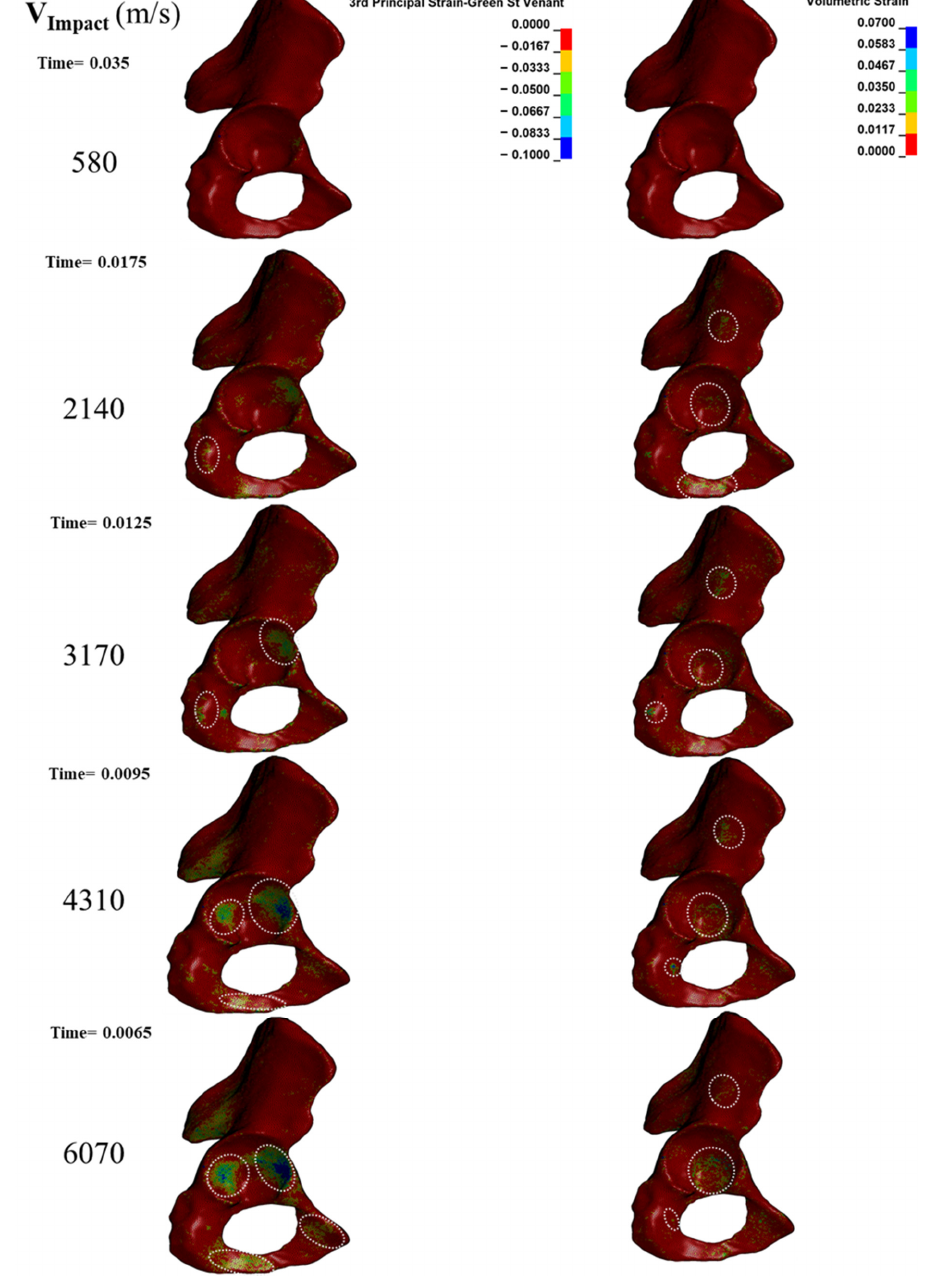
Figure 5. Effect of impact velocity on the compressive (left column) and tensile bone failure (right column) within the pelvis.